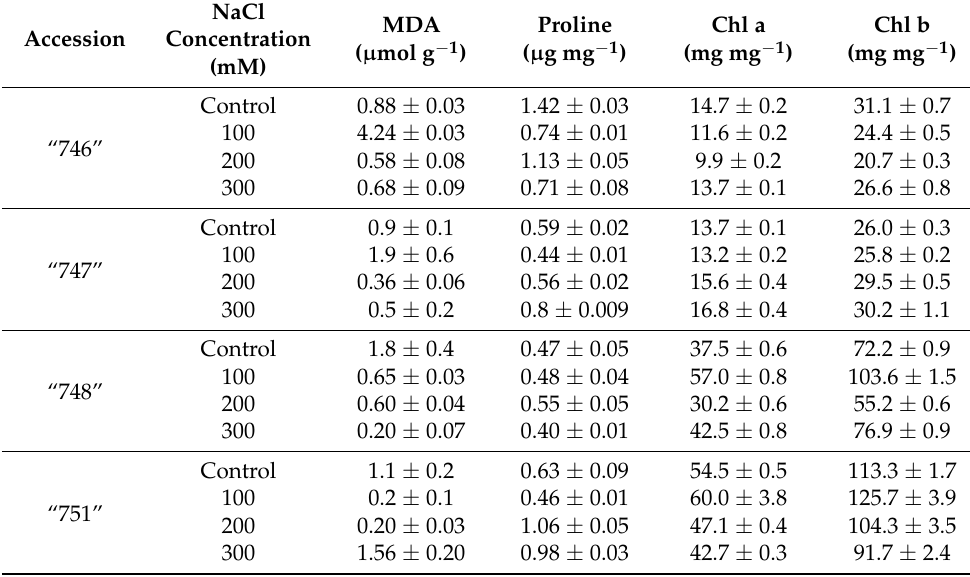
Table 7. Response of squash germplasm accession to varying salt stress levels (0, 100, 200 and 300 mM NaCl) in relation to the content of malondialdehyde (MDA), free proline and chlorophyll a and b (mean ±